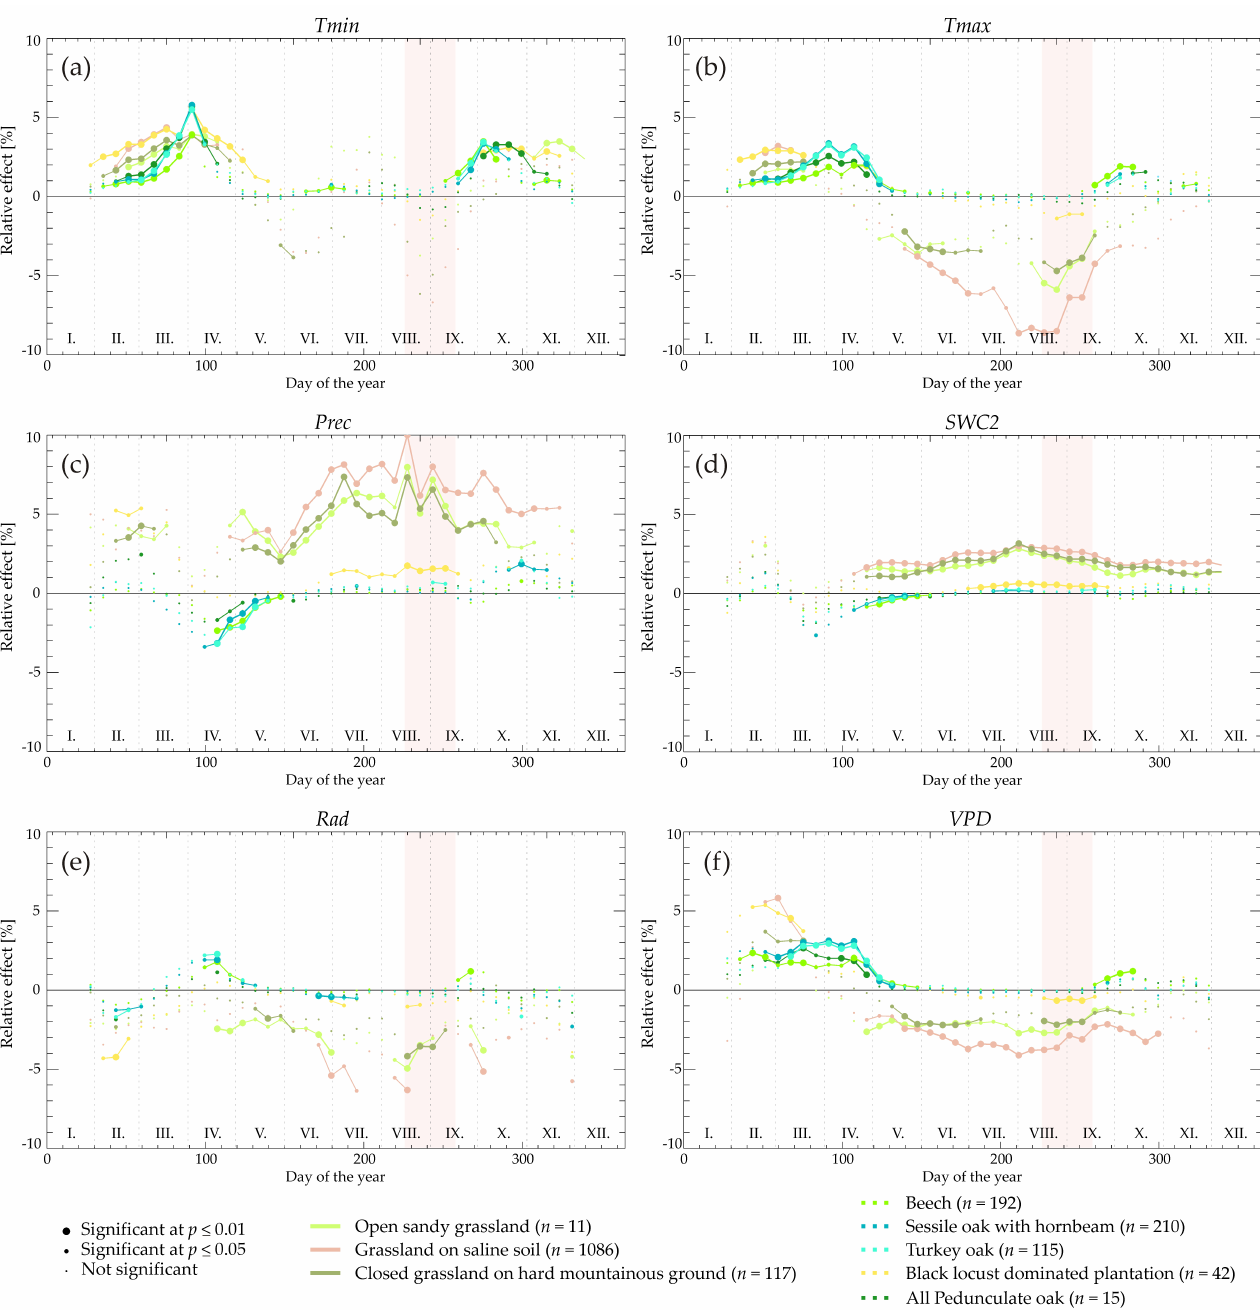
Figure 7. Relative effects of Tmin ( a ), Tmax ( b ), Prec ( c ), SWC2 ( d ), Rad ( e ) and VPD ( f ) for the investigated ecosystem groups based on NDVI and the first R -curves with a time lag of 24 days. It expresses what percentage change the NDVI showed for one reference unit change of the climate variable, where the reference units were 1 ◦ C, 1 ◦ C, 5 mm, 0.01 m 3 m − 3 , 10 W m − 2 , and 50 Pa in the case of Tmin , Tmax , Prec , SWC2 , Rad, and VPD , respectively. Pink rectangles indicate the period of interest (PI) in late summer. Similarly to the R -curves (Section 3.5), the relative effect curves for LAI are similar to the ones based on NDVI (Figure